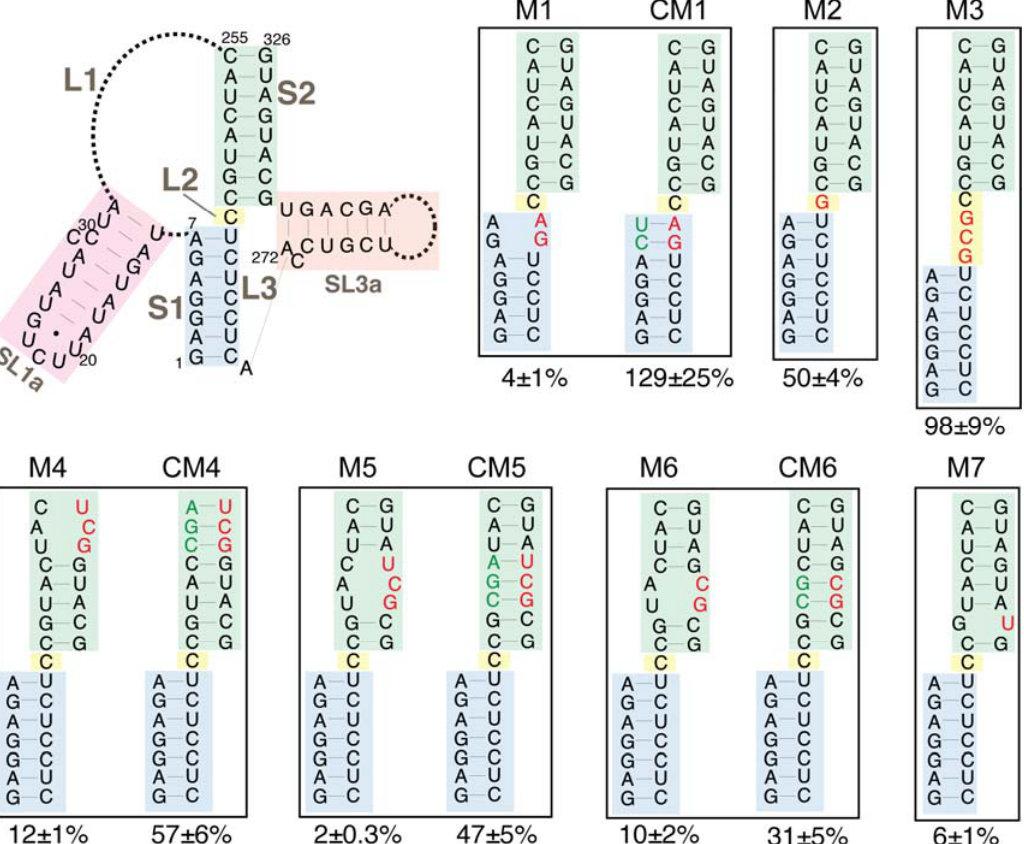
Figure 6. Retrotransposition of mini ‐ Ty1 his3AI elements with mutations in the Ty1 pseudoknot core. The schematic (top left) shows the secondary structure of the Ty1 pseudoknot core and portions of the L1 and L3 loops. Blue shading, stem S1; yellow shading, loop L2; green shading, stem S2; pink shading, SL1a hairpin, a segment of the L1 loop; orange shading, SL3a hairpin, a portion of the L3 loop. Dotted lines represent bases in loops L1 and L3 that are not shown. Labeled, boxed schematics show the nucleotide substitutions or additions in each mutant mini ‐ Ty1 his3AI element analyzed. Black letters represent wild ‐ type nucleotides; red letters represent nucleotide substitutions or additions; and green letters represent compensatory substitutions that restore base ‐ pairing with nucleotide substitutions. The percentage below each box is the median frequency of helper ‐ mediated retrotransposition of the mini ‐ Ty1 his3AI bearing the indicated mutation divided by the median helper ‐ mediated retrotransposition frequency of the mini ‐ Ty1 his3AI element with wild ‐ type Ty1 ‐ H3 sequence, +/ − the 95% confidence interval.